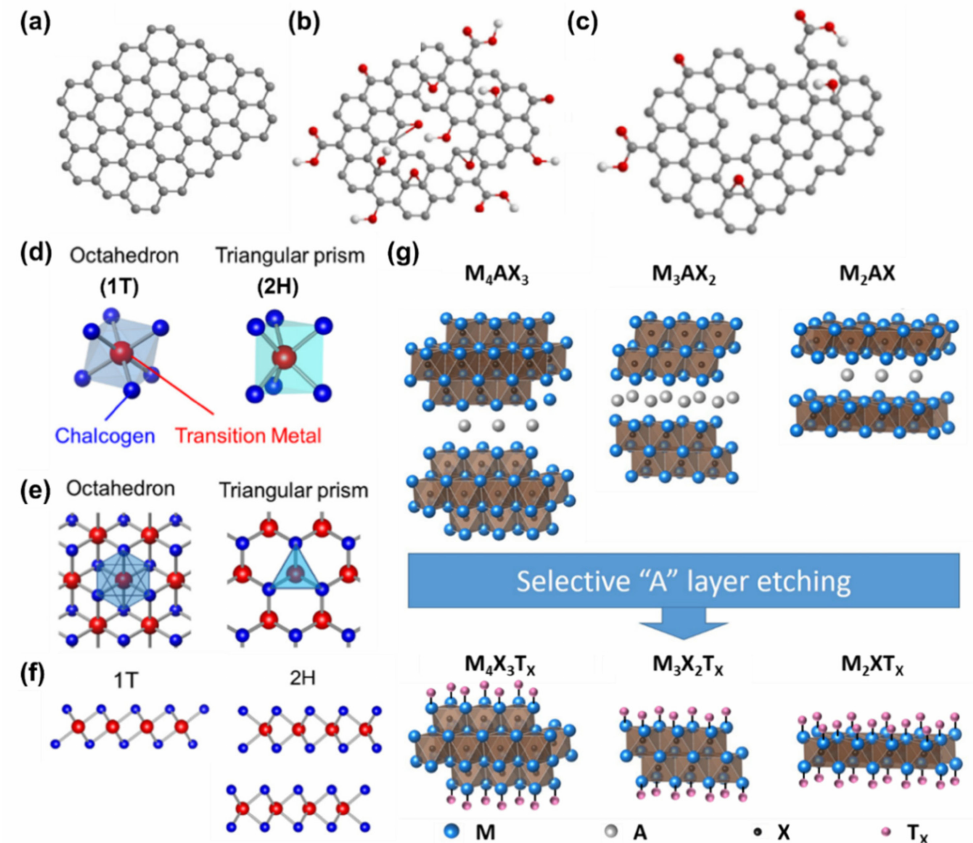
Figure 1. Schematic representation of: ( a ) graphene, ( b ) graphene oxide and ( c ) reduced graphene oxide. Figures adapted from ref. [37] Copyright Elsevier Ltd.@2020. ( d ) Octahedral (1T) and triangular (2H) prismatic structures of transition metal dichalcogenides (TMDCs). ( e ) Top and ( f ) side view